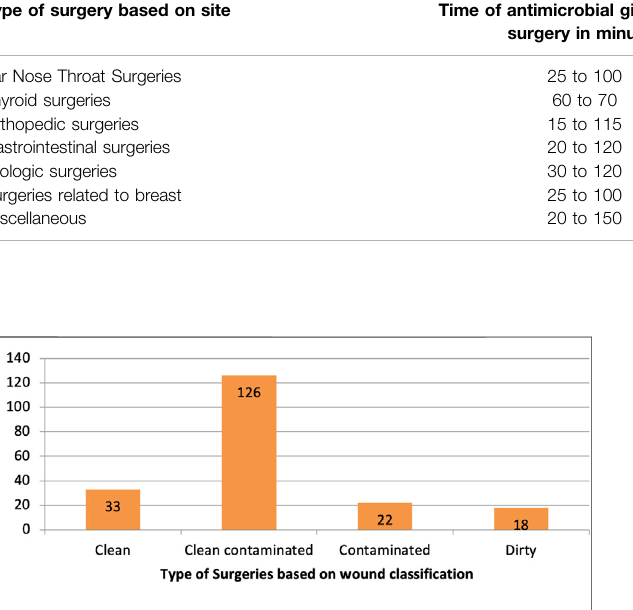
FIGURE 2 | Type of surgeries based on wound classi fi